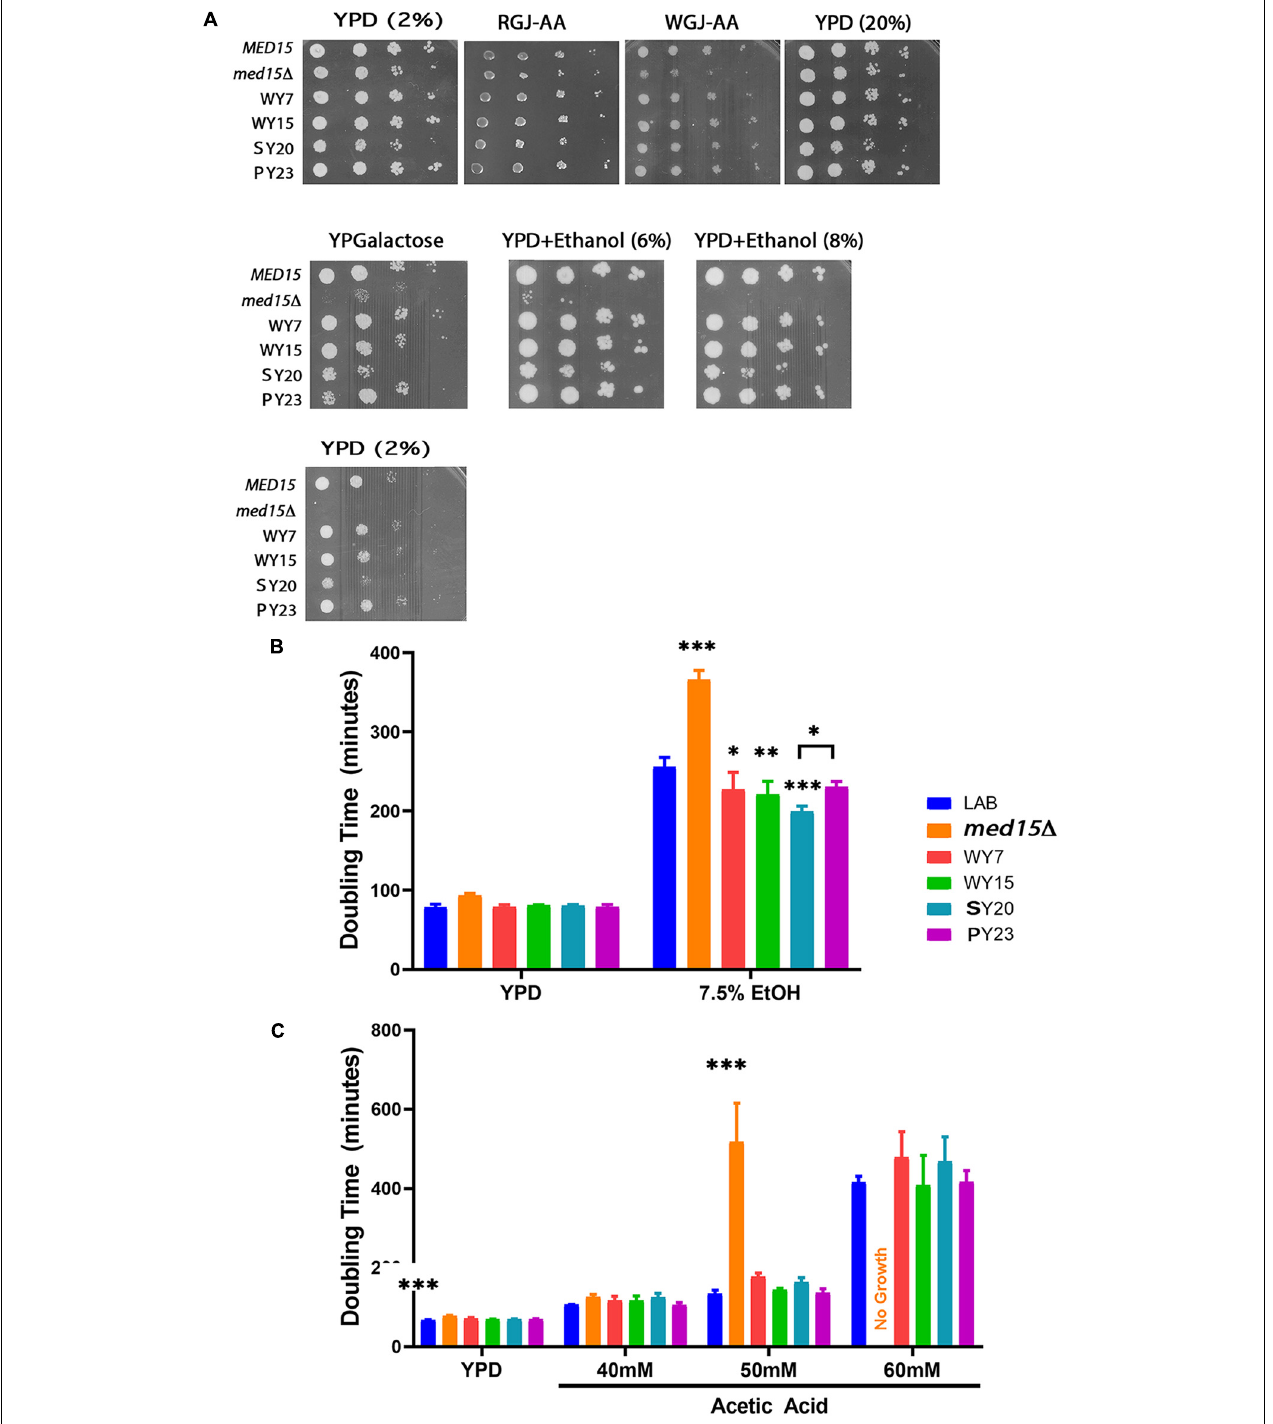
FIGURE 6 | Alcoholic beverage MED15 alleles complement all med15 phenotypes and improve growth in acetic acid and ethanol. (A) Log-phase cultures of the med15 (cid:49) strain (OY320) carrying a CEN plasmid with the indicated MED15 allele were serially diluted and spotted on YPD media with 2% or 20% glucose YPD media with 2% or 20% glucose (YPD (2%)) or (YPD (20%)), YPD (2%) with added ethanol (YPD + Ethanol (6%)) (YPD + Ethanol (8%)), YP media with 2% galactose instead of glucose (YPGalactose), supplemented red grape juice (RGJ-AA), and supplemented white grape juice (WGJ-AA) media. Incubation temperatures were as indicated. (B,C) Doubling times derived from growth curves of the med15 (cid:49) strain carrying different MED15 alleles in YPD with or without indicated amounts of ethanol (B) or acetic acid (C) . For analyses in (B,C) , data points are the averages of 3 biological replicates (transformants) and error bars are the standard deviation of the mean. Significance was determined using ANOVA analysis with a Tukey post-hoc test. ∗ , p ≤ 0.05; ∗∗ , p ≤ 0.01; ∗∗∗ , p ≤ 0.001.